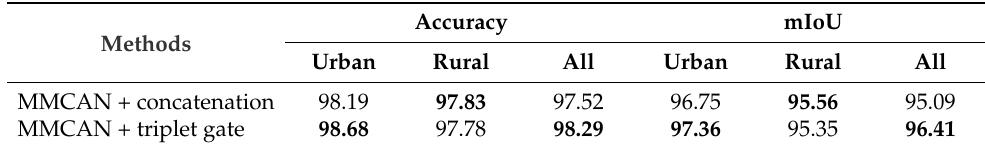
Table 2. Ablation study on fusion strategies.